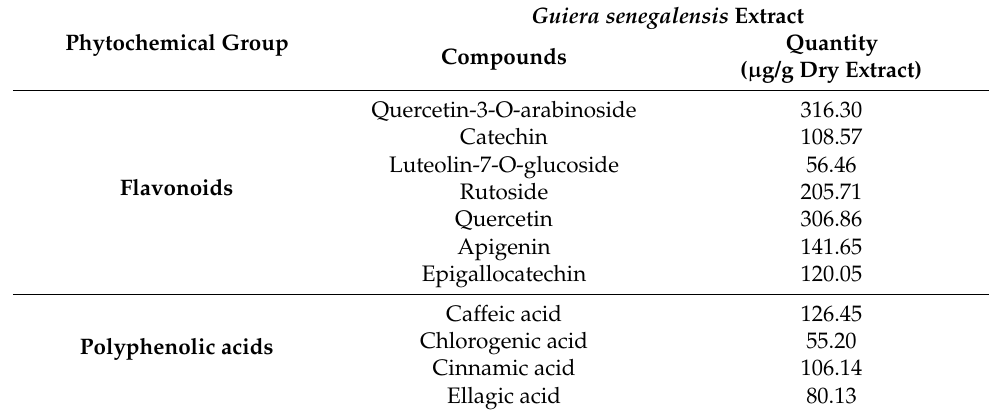
Figure 1. HPLC ‐ PAD chromatography profile at ( A ) 245 nm and ( B ) 275 nm for the flavonoids and polyphenolic acids of the Guiera senegalensis leaf hydroethanolic extract. Table 1. Active constituents identified in Guiera senegalensis extract sample .